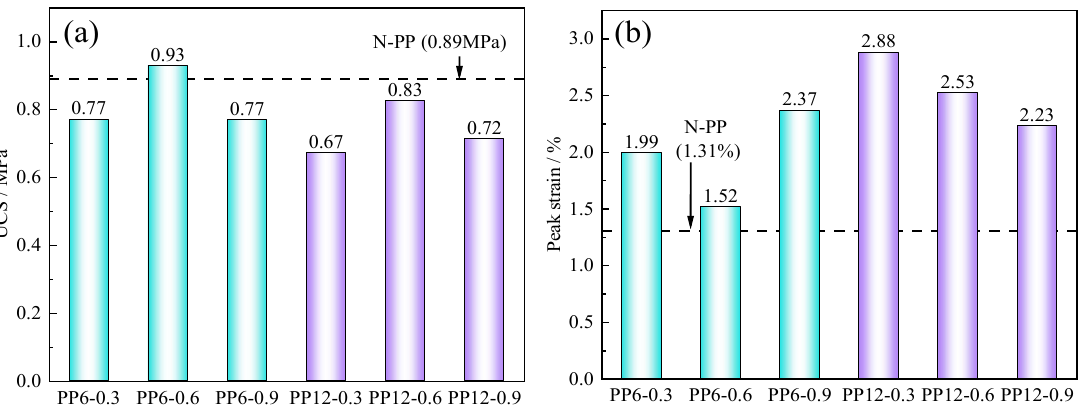
Figure 3. UCS and peak strain of FRCTWRF samples: ( a ) UCS; ( b ) peak strain. Cyan means PP6; purple means PP12